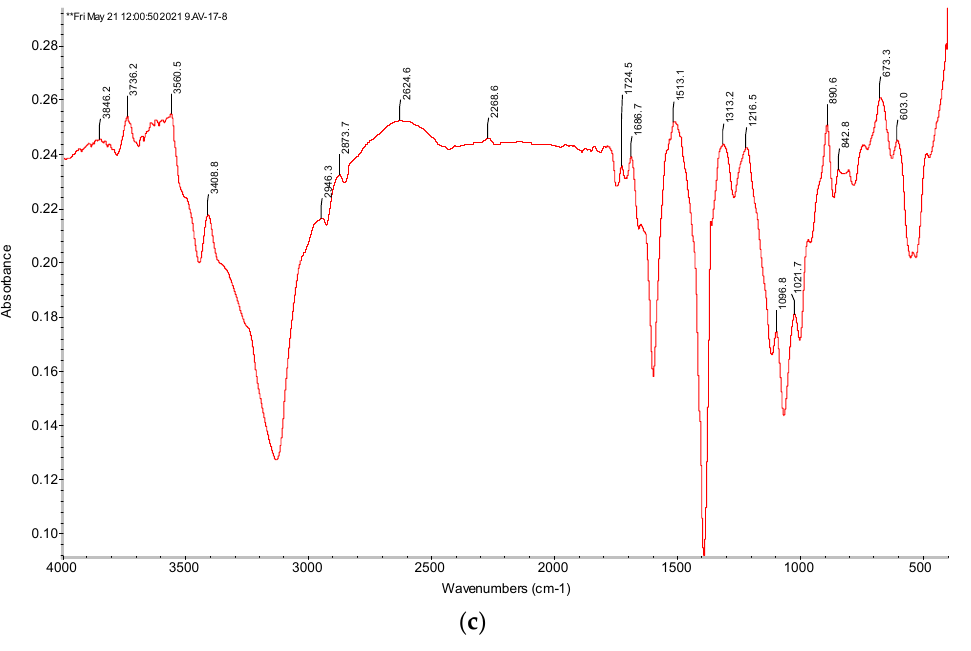
Figure 10. FTIR spectra ( a ) AB-17-8; ( b ) AB-17-8 0:6; ( c ) AB-17-8 1:5. 3.3.2. Thermogravimetric Analysis (TGA) of Amberlite IR120; AB-17-8 and the Interpolymer Pair Amberlite IR120:AB-17-8 = 1:5 As seen in Figure 11, thermal destruction of europium nitrate takes place from 350 ◦ C to 440 ◦ C. It is indicated by a strong decrease of mass loss (the parameter decreases from 80% to 60%), and also it should be noted that rate of mass loss increases in this temperature region.